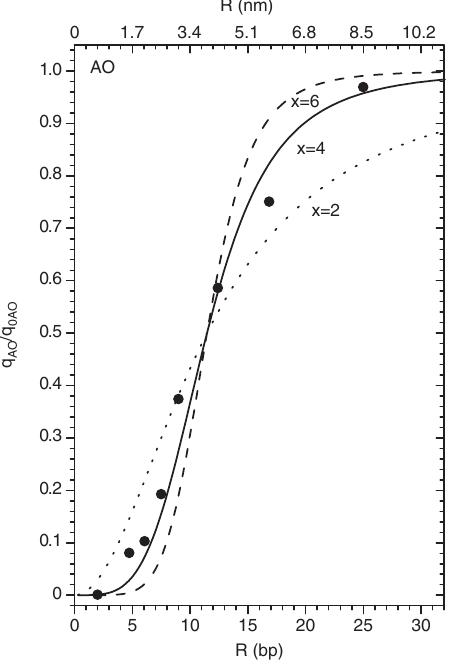
Figure 16 Ignition curves of AO fluorescence depending on the distance between AO and EB intercalated in DNA.